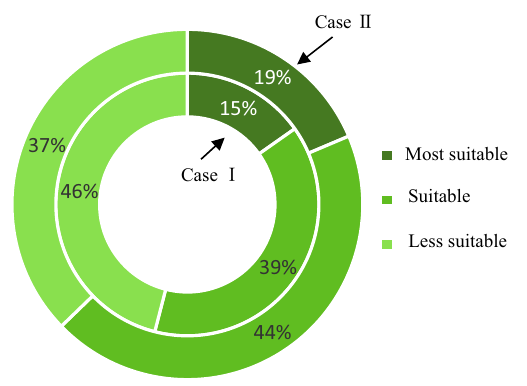
Fig. 9 Distribution of zones’ suitability for Case I and II analyses